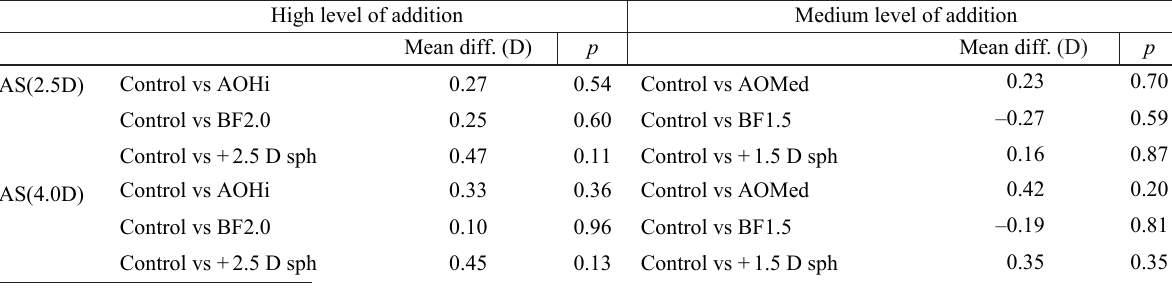
Table 3. Comparison of accommodative lag differences without correction and with the specified correction type of contact lenses, fixating the stimulus at 40 cm and 25